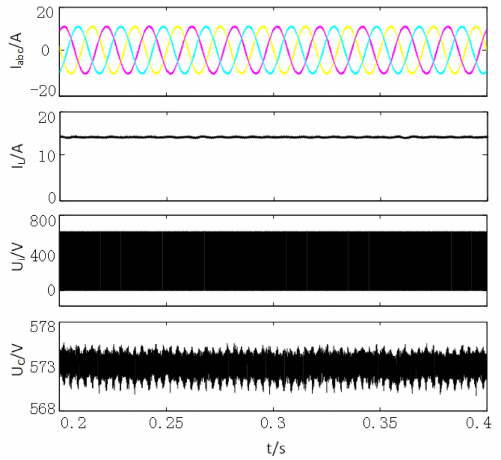
Figure 10. Simulation waveforms in the traditional PWM scheme.